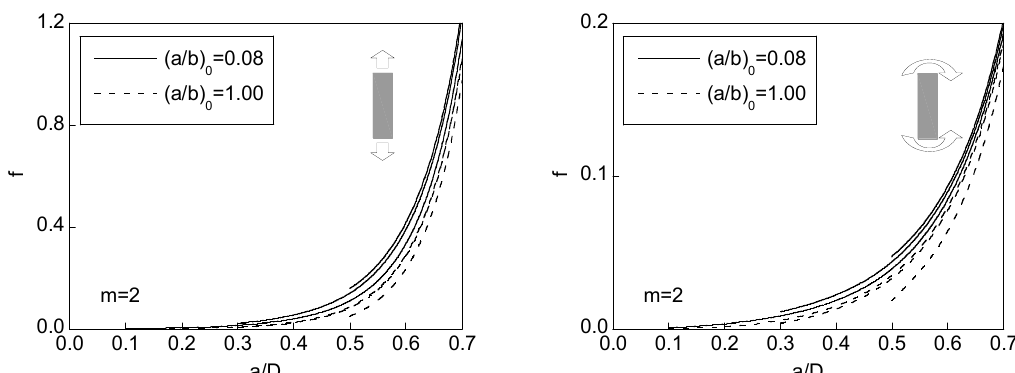
Figure 8: Evolution of the dimensionless compliance f with crack growth (represented by the relative crack depth a / D ) for m =2, starting from different initial crack geometries under tension loading (left) and bending moment (right).